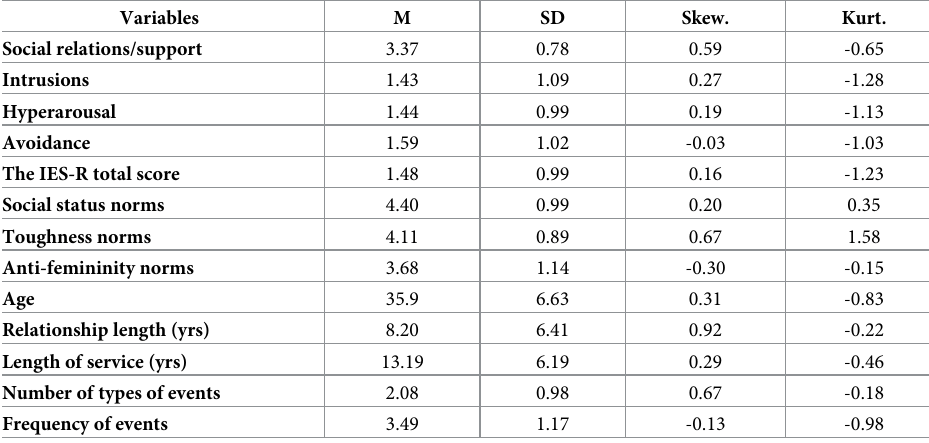
Table 2. Descriptive statistics.